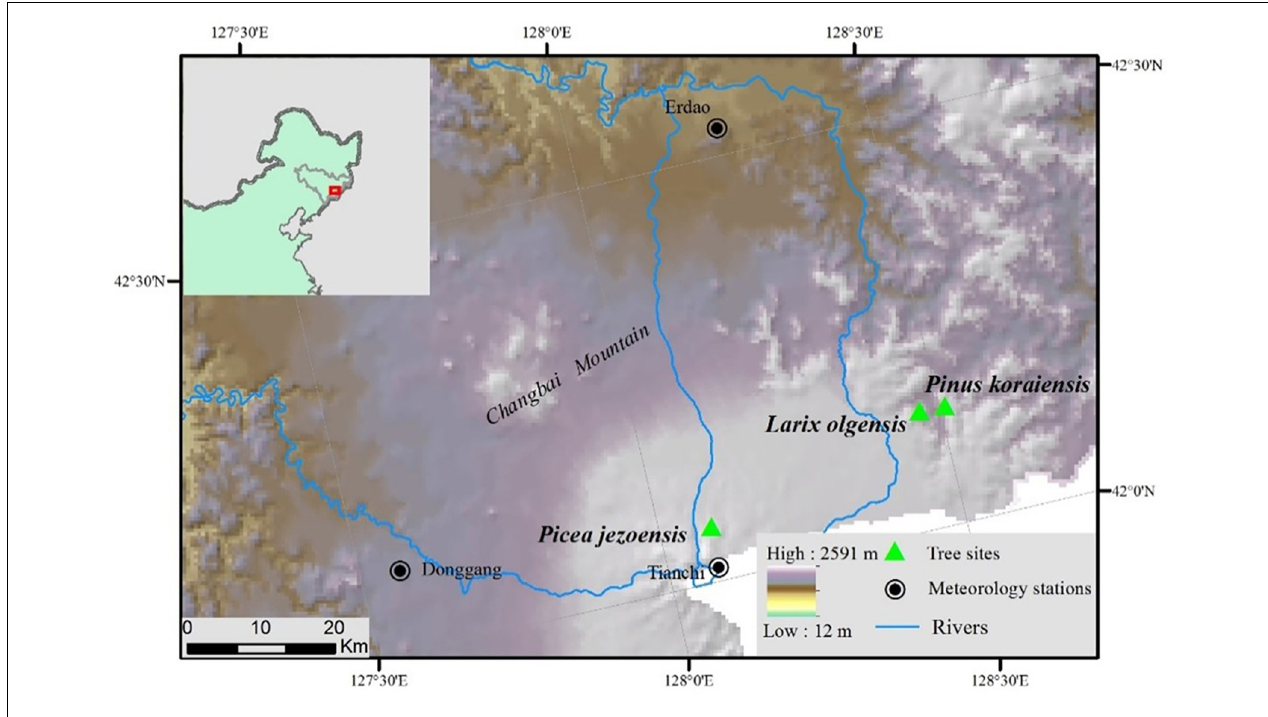
FIGURE 1 | Locations of sample sites and meteorological stations in the study area.